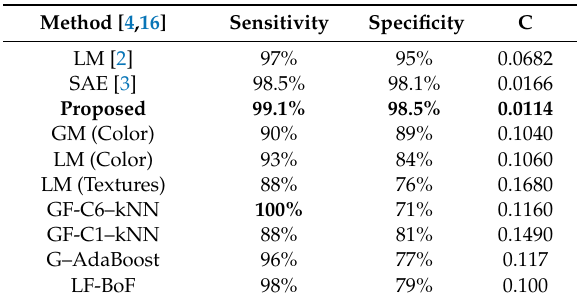
Table 1. Benchmarks comparison for the proposed pipeline.